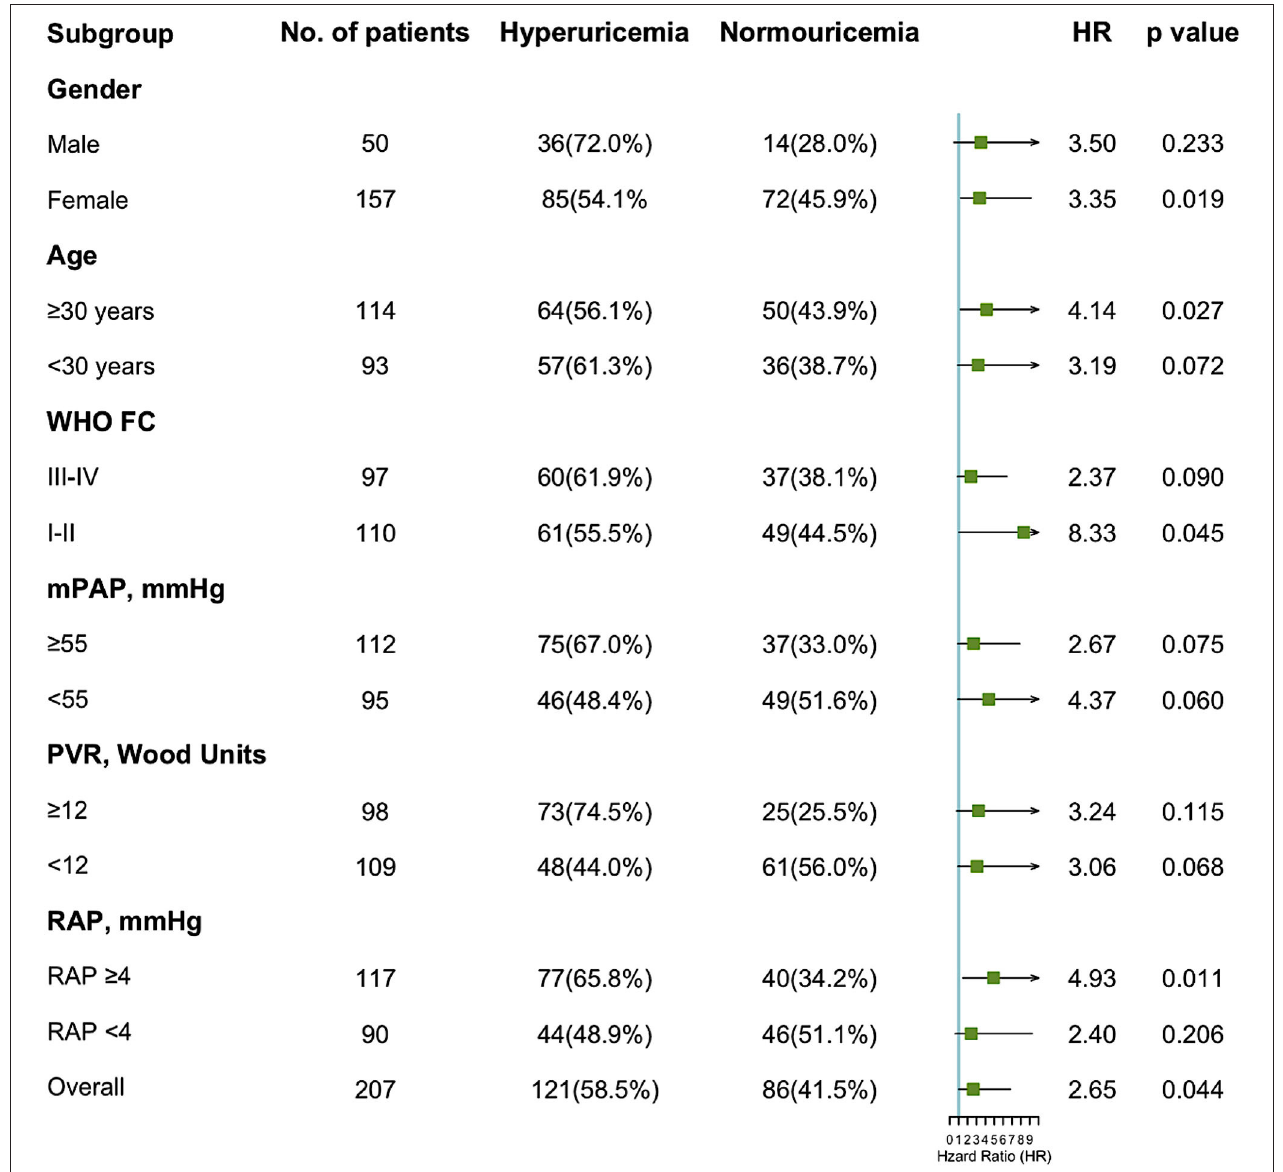
FIGURE 3 | Forest plot of hazard ratios by patient subgroups. HR, hazard ratio; WHO FC, World Health Organization functional classes; mPAP, mean pulmonary artery pressure; PVR, pulmonary vascular resistance; RAP, right atrial